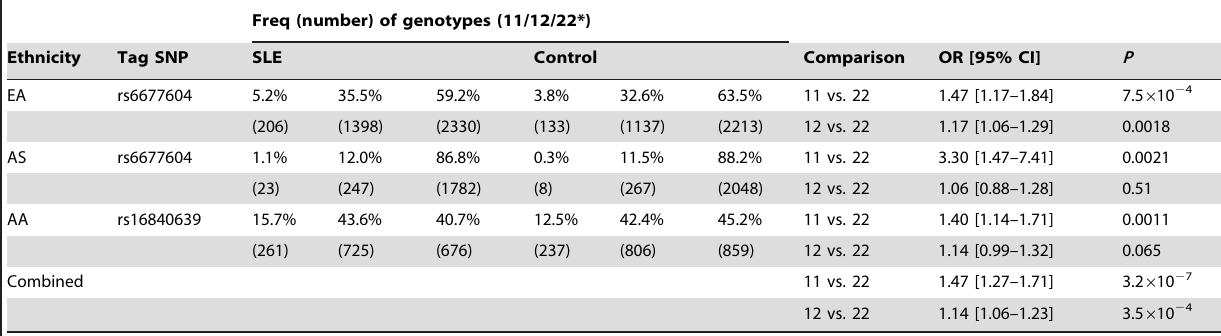
Table 3. Dosage-dependent risk effect of the CFHR3-1 D